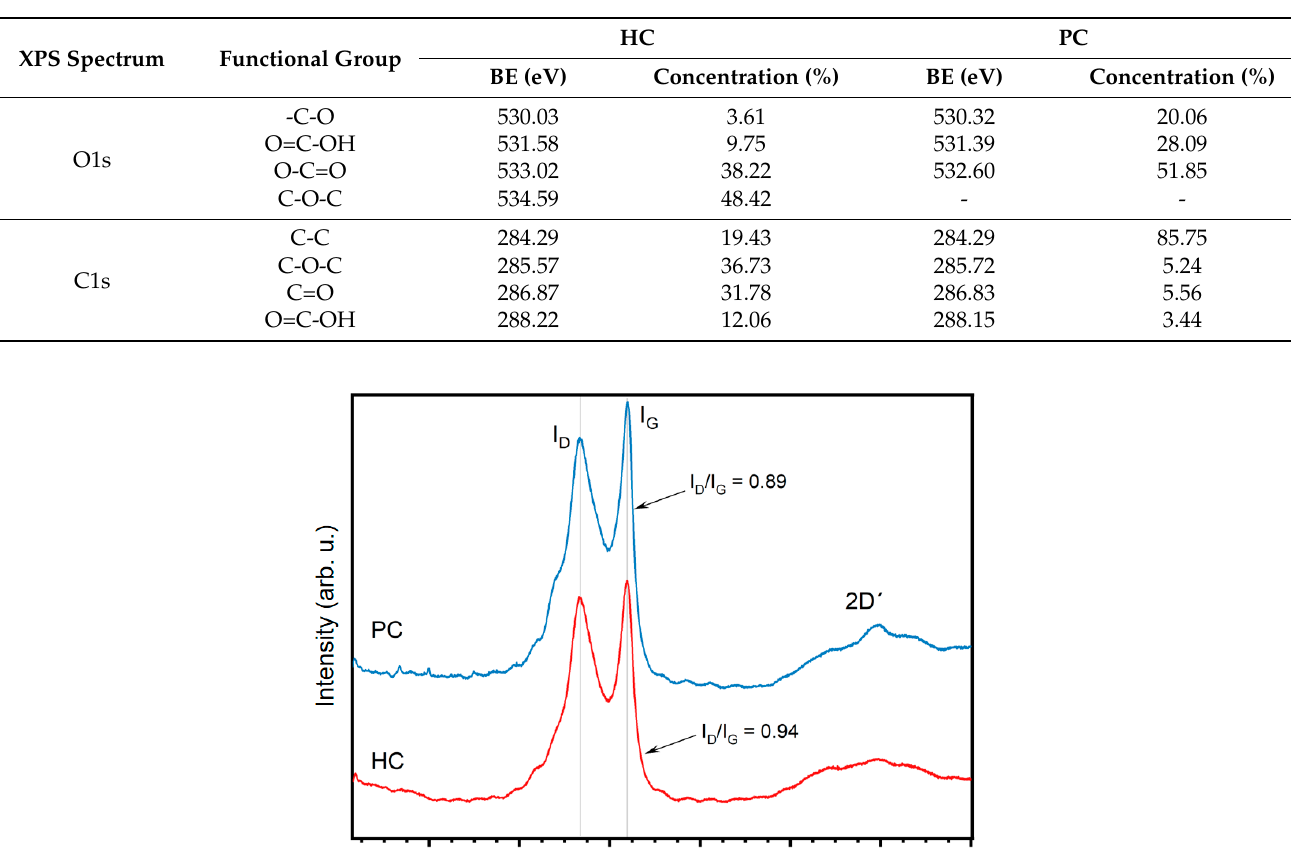
Table 3. Atomic surface concentration (%) of functional groups on HC and PC obtained from the XPS O1s and C1s core level spectra.